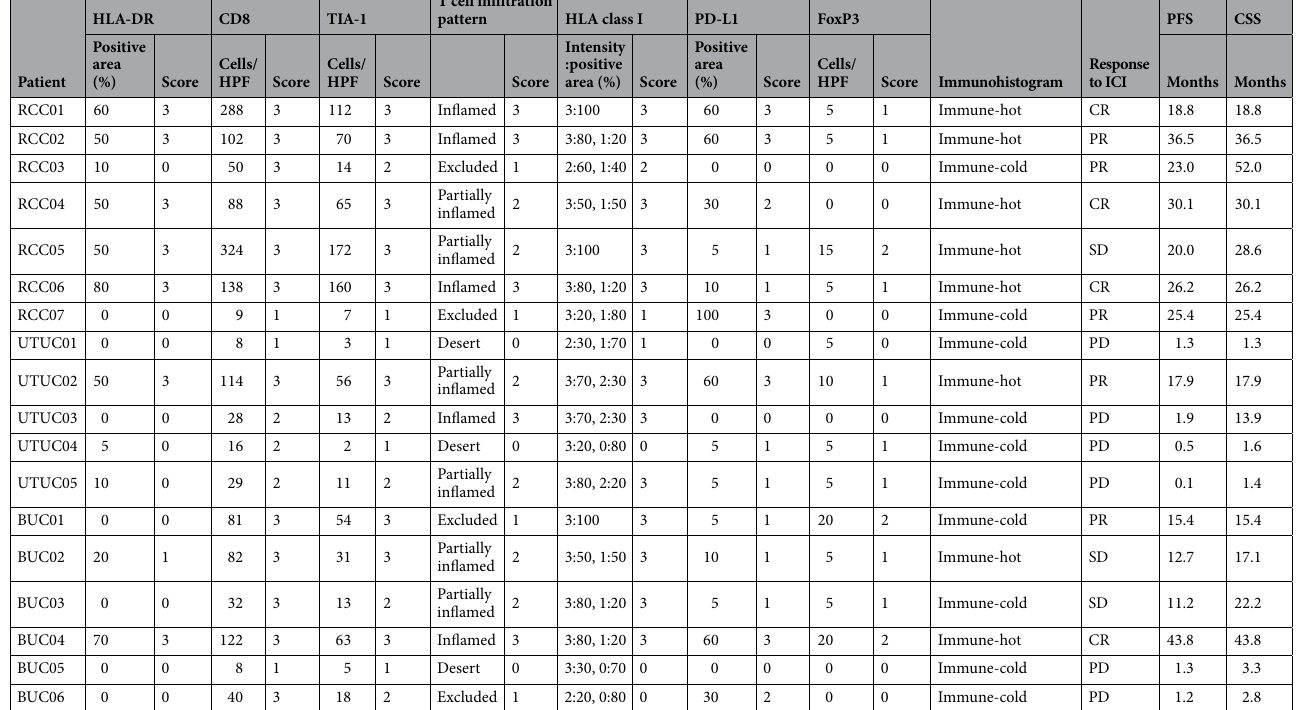
Table 2. Results of immunohistochemical analysis and treatment outcomes of ICI therapy. RCC, renal cell carcinoma; UTUC, upper tract urothelial carcinoma; BUC, bladder urothelial carcinoma; ICI, immune checkpoint inhibitor, PFS, progression free survival; CSS, cancer specific